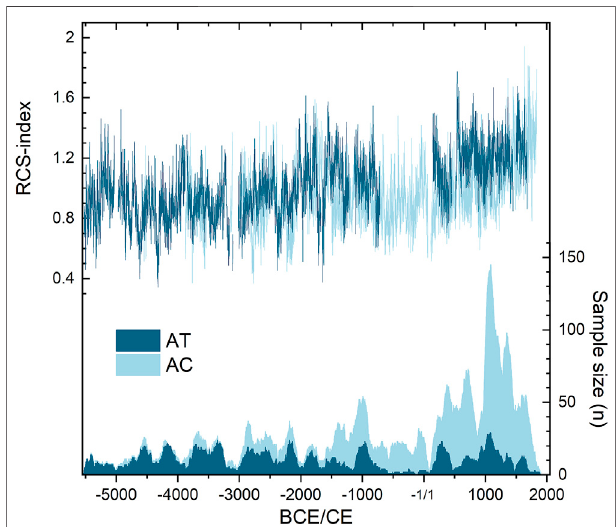
FIGURE 3 | Chronologies of the minimum blue channel light intensity (BI). The BI data are shown as their mean indices shown for replication n ≥ 5 series per year after the Regional Curve Standardization (RCS), representing the Arctic timberline (AT) and Arctic Circle (AC) sites, with the number of subfossil samples.